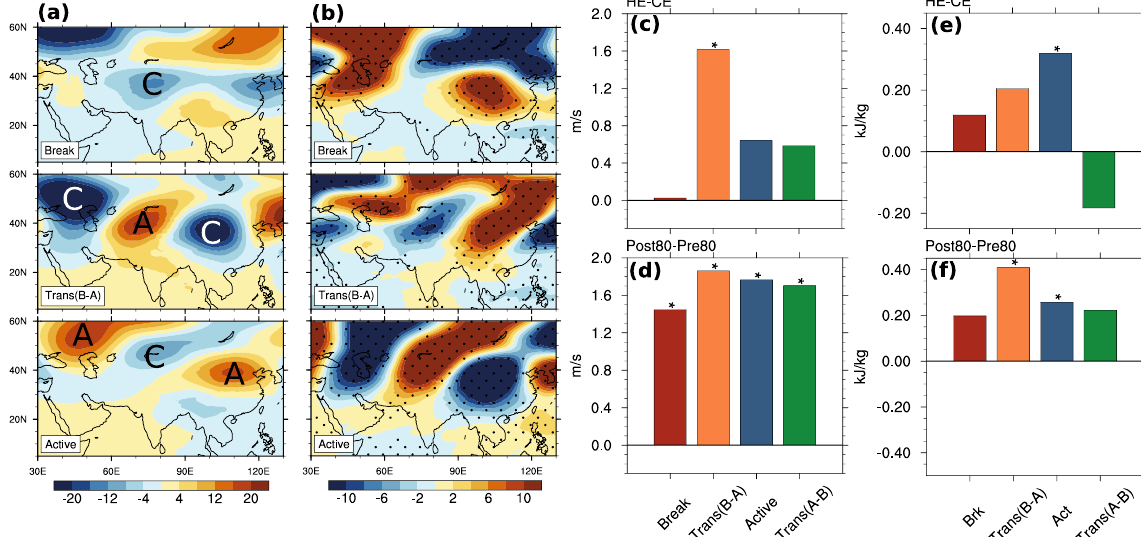
Figure 3. Possible mechanism for change in rainfall. Anomalous geopotential height at 200hPa during ( a ) break, transition (break-active), and active phases in the CE. ( b ) Same as ( a ) but for HE–CE, showing the change in HE compared to CE. Change in vertical wind shear ( U 200 hPa − U 850 hPa ) averaged over the northern Indian region (20°N to 35°N and 65°E to 95°E) in different phases (break, transition (break-to-active), active, and transition (active-to-break), respectively) from ( c ) Model and ( d ) Observations. Change in VMS over the CI region in different phases from ( e ) Model and ( f ) Observations. Observational analysis here is done using NCEP-NCAR Reanalysis-1 35 data. Trend in global mean temperature is subtracted before calculating VMS. Units are in m for geopotential height, m / s for wind shear, and kJ / kg for VMS. Dotted regions in ( b ) and asterisks in ( c – f ) indicate where the changes are significant at 10% level (using t-test). ‘A’ and ‘C’ in ( a ) and ( b ) indicate the anticyclonic and cyclonic structures of winds at upper troposphere, respectively. Figures are generated using NCAR Command Language 6.3.0